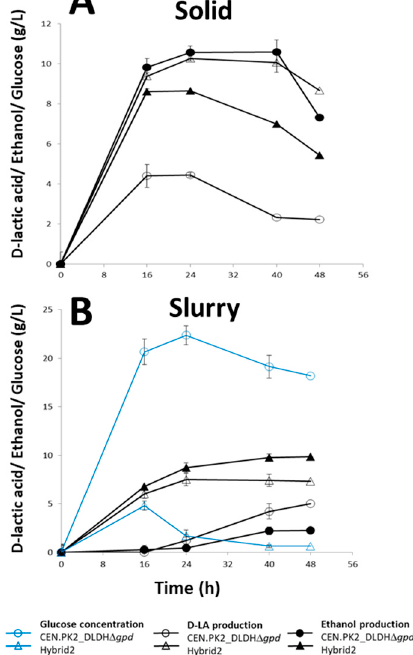
Figure 5. Simultaneous saccharification and fermentation (SSF) of D-lactic acid and ethanol by CEN.PK2_DLDH ∆ gpd and hybrid2: ( A ) SSF of washed solid fraction of alkaline-pretreated sugarcane bagasse supplemented with Cellic ® Ctec2 at 30 FPU/g biomass. ( B ) SSF of whole slurry of alkaline-pretreated biomass (6% solid loading) supplemented with Cellic ® Ctec2 at 30 FPU/g biomass. Glucose concentration in SSF medium is shown by the solid blue line; parental strain CEN.PK2_DLDH ∆ gpd (open circle), hybrid2 (open triangle). Production of D-lactic acid is shown by the solid black line; parental strain CEN.PK2_DLDH ∆ gpd (open circle), hybrid2 (open triangle). Production of ethanol is shown by the solid black line; CEN.PK2_DLDH ∆ gpd (closed circle), hybrid2 (closed triangle). All SSF experiments were performed in triplicate at the temperature of 30 °C with shaking at 200 rpm.